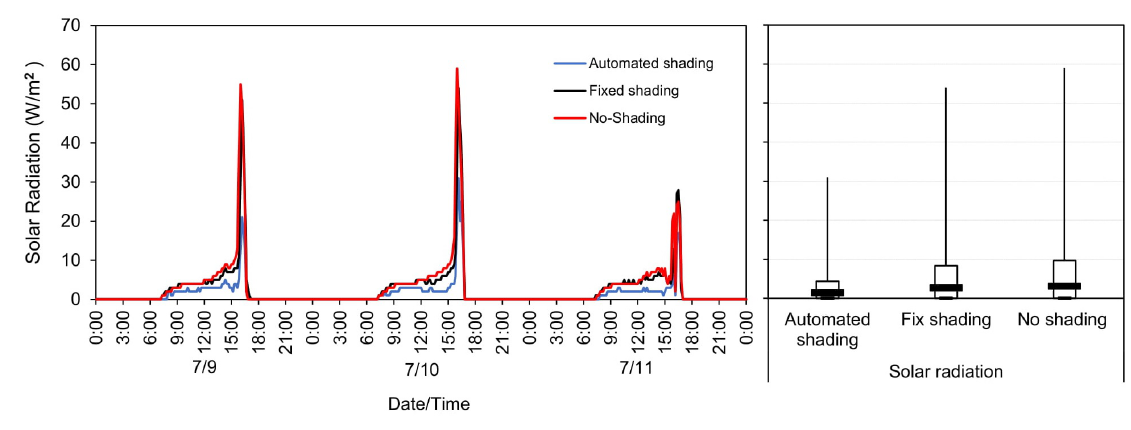
Fig. 8. Profile of solar radiation in the TH1, TH2 and TH3. Table 3. Comparison of indoor thermal environments during the peak hours (14.00-16.00) in the three test houses. 5% percentile Indoor thermal parameters Type of shading devices